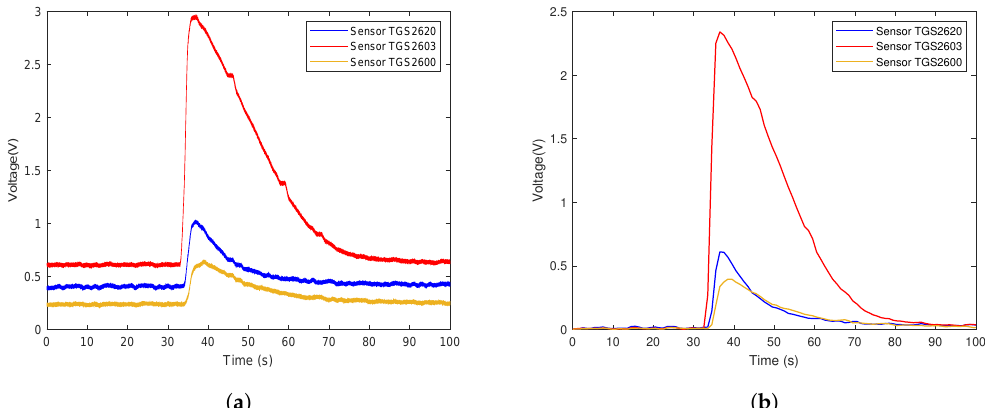
Figure 10. Time series of ethanol raw data and the data after preprocessing in the second experiment. ( a ) Shows the representative example of the time series of the original response curves of the sensor array for gas ethanol. ( b ) Shows the results after preprocessing.